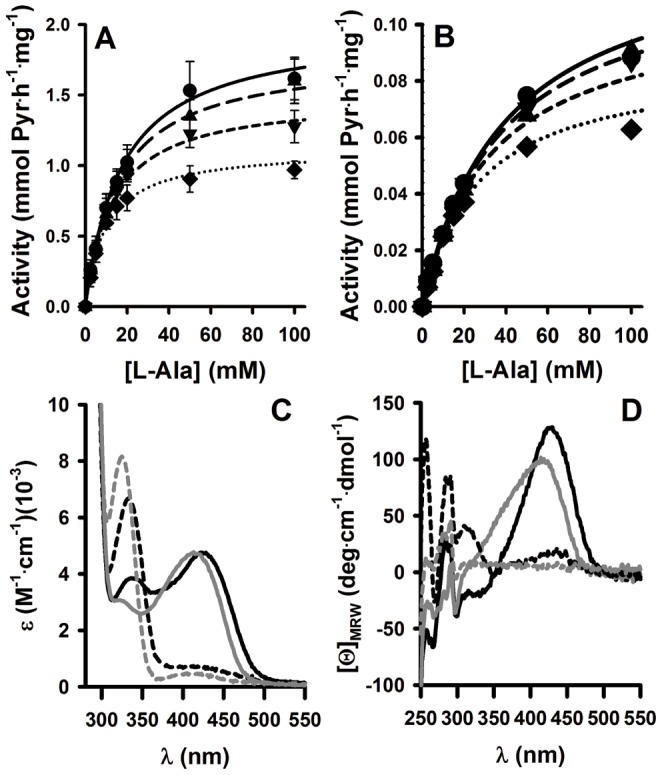
Functional characterization of WT and p.H83R.A and B) Enzyme activity measurements for WT (A) and p.H83R (B) at different L-Ala concentrations in the presence of 0.25 mM (diamonds), 0.5 mM (down triangles), 1 mM (up triangles) and 2 mM (circles) glyoxylate. Data in panel A are means±s.d from four independent measurements while data in panel B are means from two independent measurements. Lines are best fits for the different glyoxylate concentrations obtained from global fittings using a double-displacement mechanism. C and D) Absorption (C) and circular dichroism (D) spectra for holo-WT (black) and holo-p.H83R (grey) acquired upon incubation for at least 10 min in the absence (continuous lines; PLP bound) or presence (dashed lines; PMP bound) of 500 mM L-alanine.